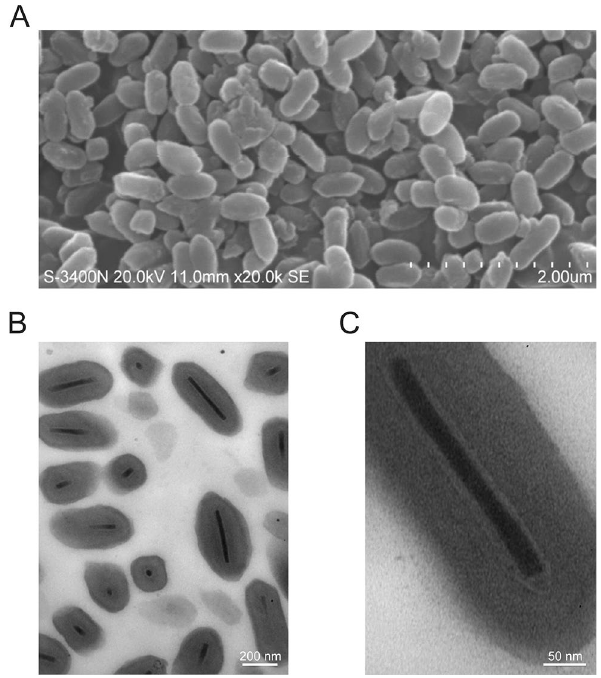
Figure 1. A scanning electron micrograph of MyunGV-A ( A ) and transmission electron micrograph of MyunGV-A ( B , C